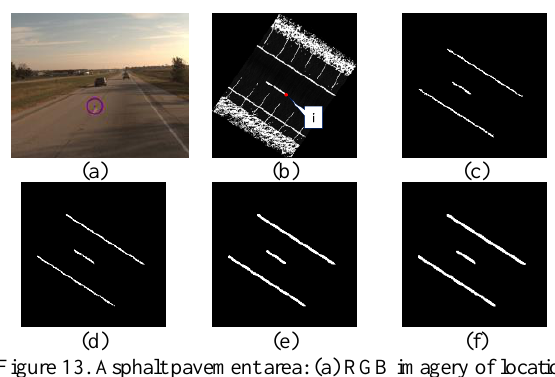
Figure 13. Asphalt pavement area: (a) RGB imagery of location i, (b) original intensity image and predicted lane marking images from (c) original intensity thresholding, (d) normalized intensity thresholding, (e) U-net model 1, and (f) U-net model 2.